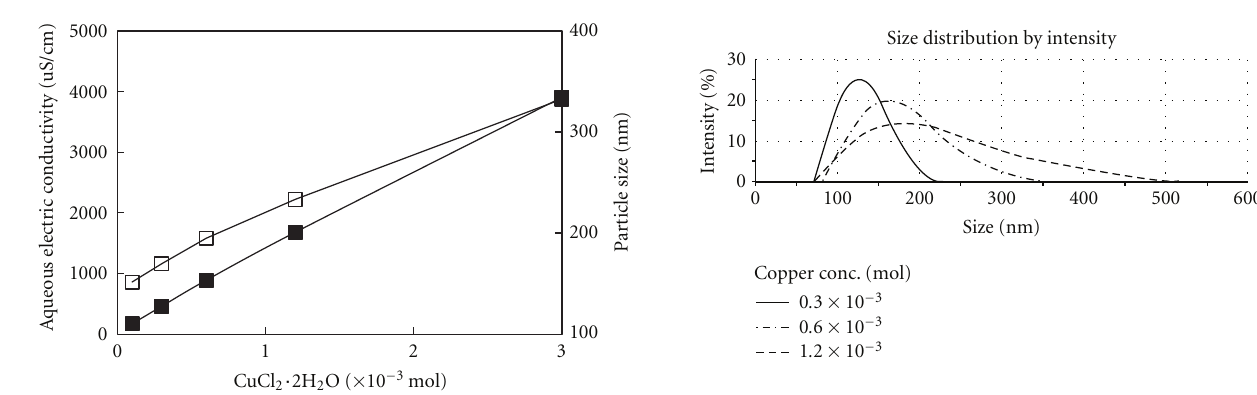
Figure 6: Particle size distributions at di ff erent copper ion concen- trations.